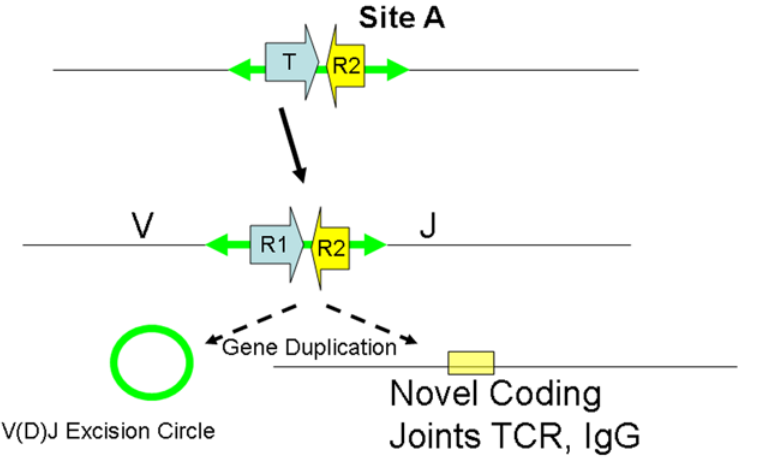
Figure 3. The ‘‘big bang’’ or ‘‘RAG-transposon insertion model’’ of the origins of the acquired immune system. As shown , a transposon inserted at a site in the genome denoted Site A can transcribe an mRNA encoding a bi-molecular transposase consisting of RAG-1 and RAG-2 like proteins from promoters in flanking sequences. Expression of the transposase then can excise a transposon from site A or another site (large arrows) at the transposon termini and insert the transposon and another site termed site B with an immunoglobulin or T-cell receptor gene. Subsequent excision of V(D)J RSS that resemble transposon termini results in circular episomes and repaired empty sites in immunoglobulin and T cell receptor genes. Multiple cycles of RAG transposon insertion and excision from primordial immunoglobulin and T-cell receptor like genes and insertion of the RAG transposon at other sites in the genome such as the current RAG locus with subsequent gene amplification of the immunoglobulin and T cell receptor gene families could result in the current structure of these genetic loci.